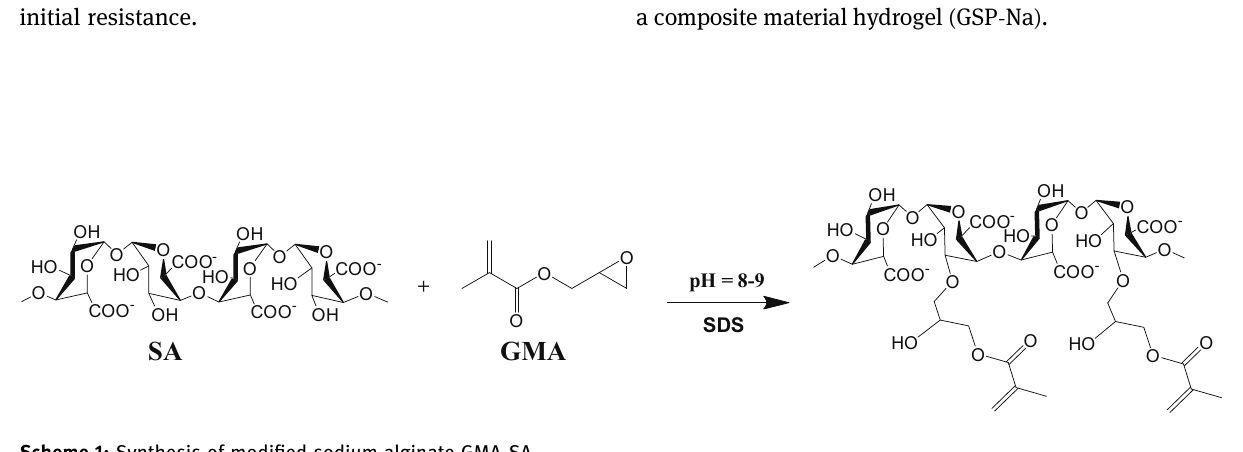
Scheme 1: Synthesis of modi fi ed sodium alginate GMA -